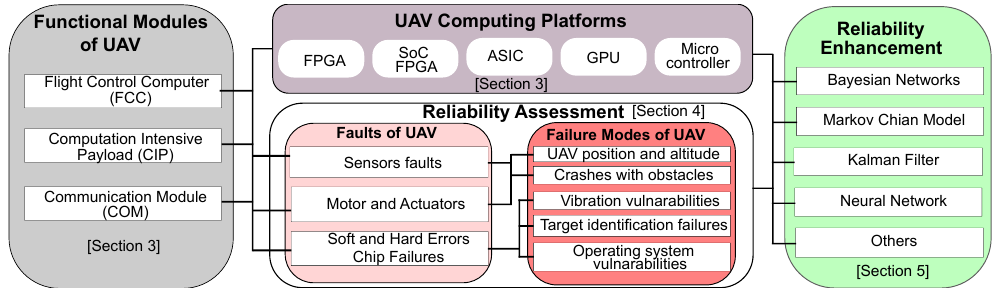
Figure 1. The overall structure of this